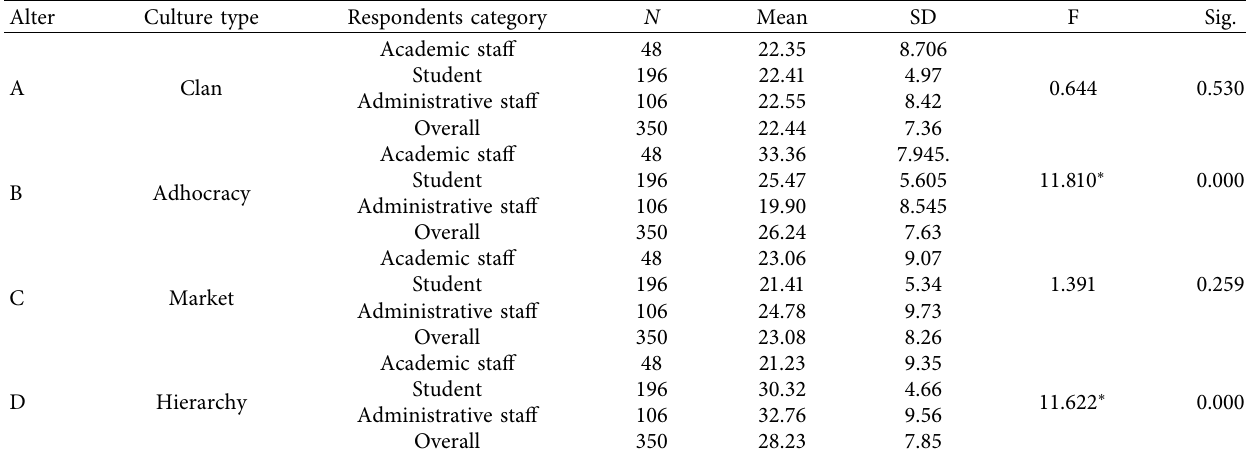
Table 3: In the current situation.